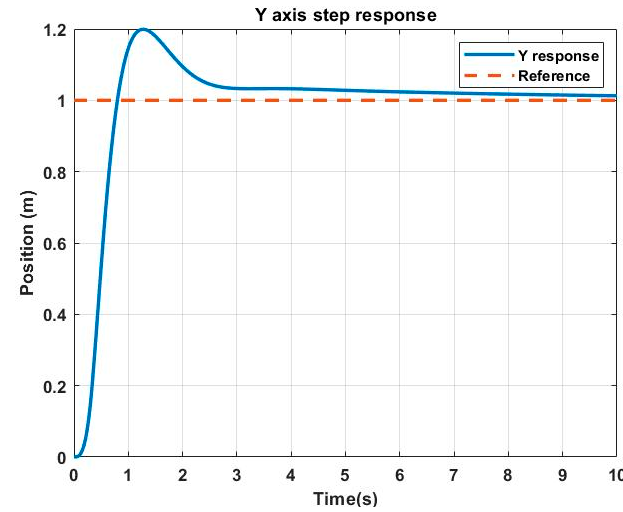
Figure 21. PID step response in X axis.